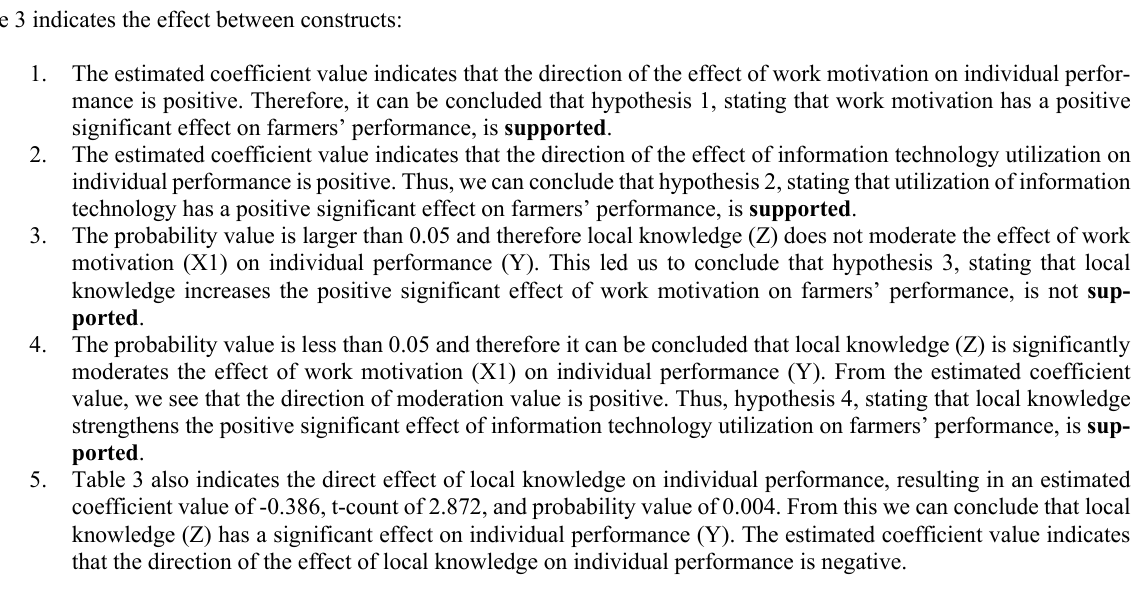
Table 3 indicates the effect between